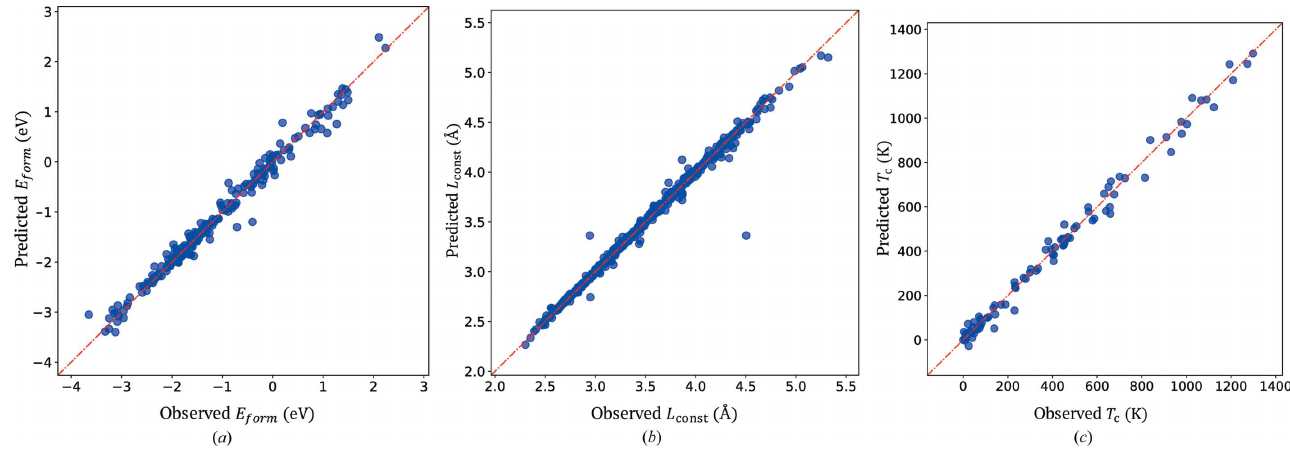
Figure 4 (From left to right) Observed and predicted target variables taking ensemble averaging of 139 ( E form problem), 57 ( L const problem) and 59 ( T C problem) best prediction models including similarity measure information. Ensemble models yield PAs with R 2 scores of 0.982 (MAE: 0.101 eV) for predicting the E form problem, 0.992 (MAE: 0.011 A˚ ) for predicting the L const problem and 0.991 (MAE: 24.16 K) for predicting the T C